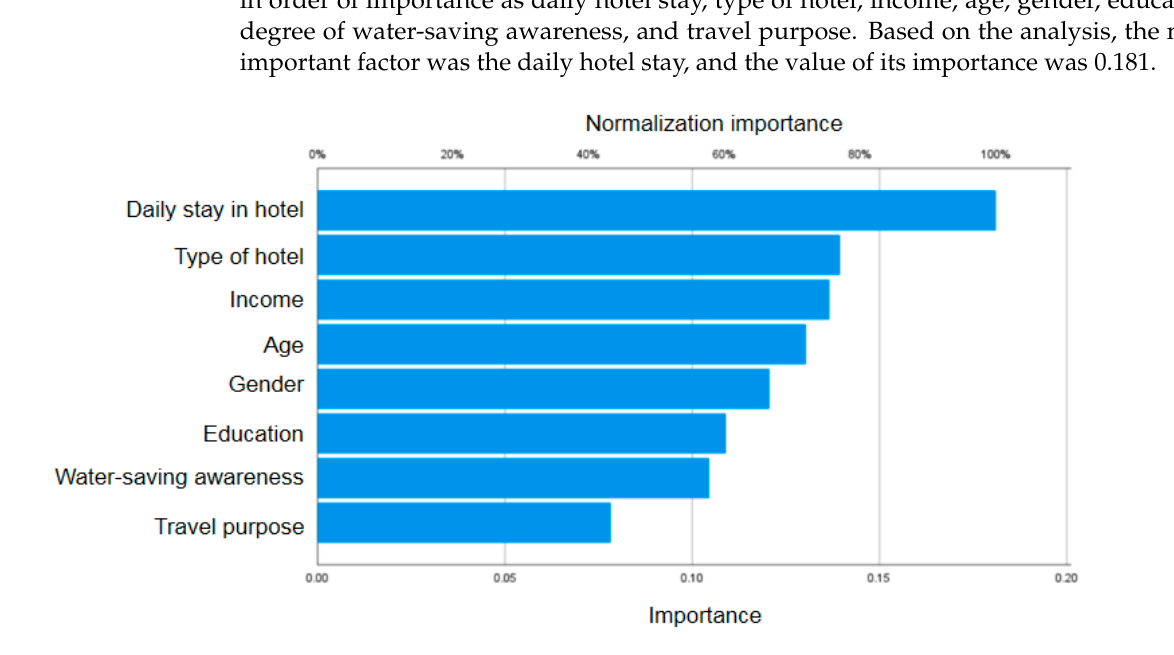
Figure 5. Importance of in fl uencing factors on the comprehensive direct water-use behavior of hotel consumers. hotel